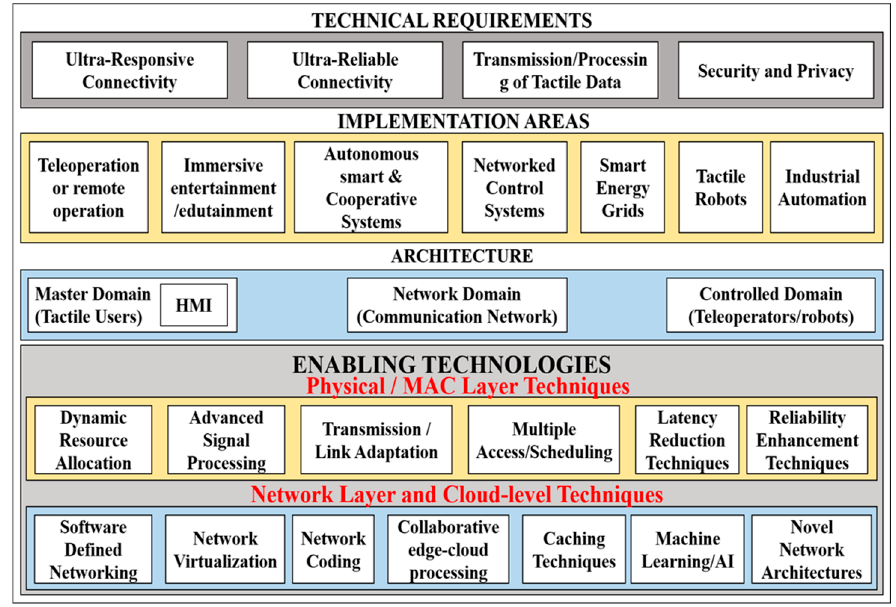
Figure 15. A generalized framework for ΤΙ in the beyond 5G era (adapted from